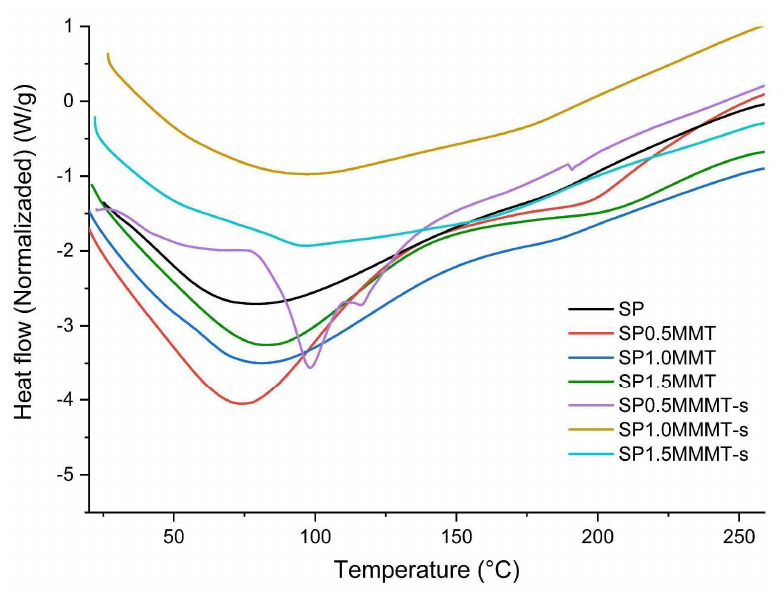
Figure 7. DSC thermograms of bionanocomposite films at different concentrations of clay and ultrasound treatment.